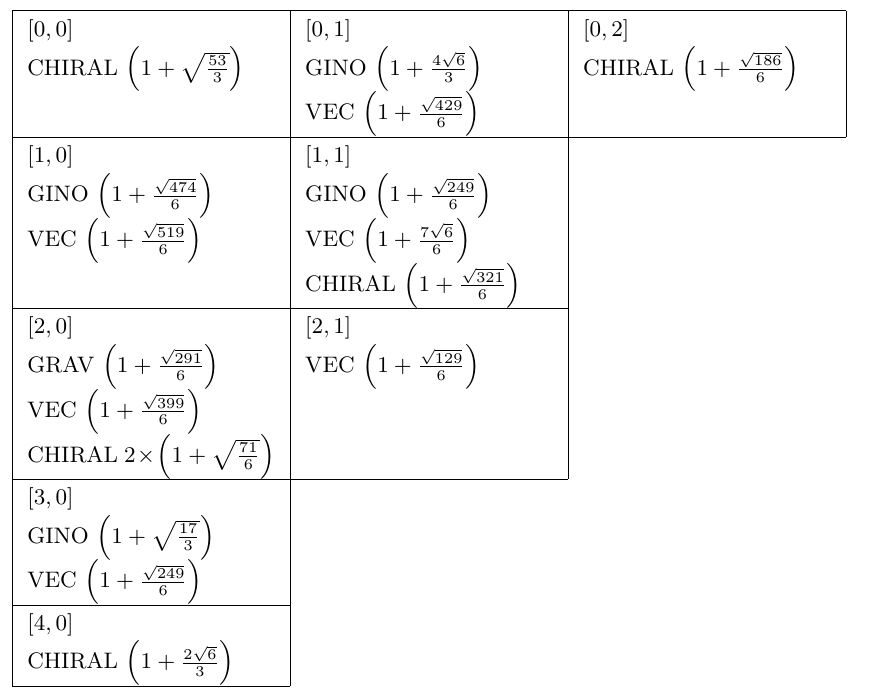
Table 9 . Supermultiplets at KK level n = 2 for the N = 1 G 2 -invariant AdS 4 solution of type